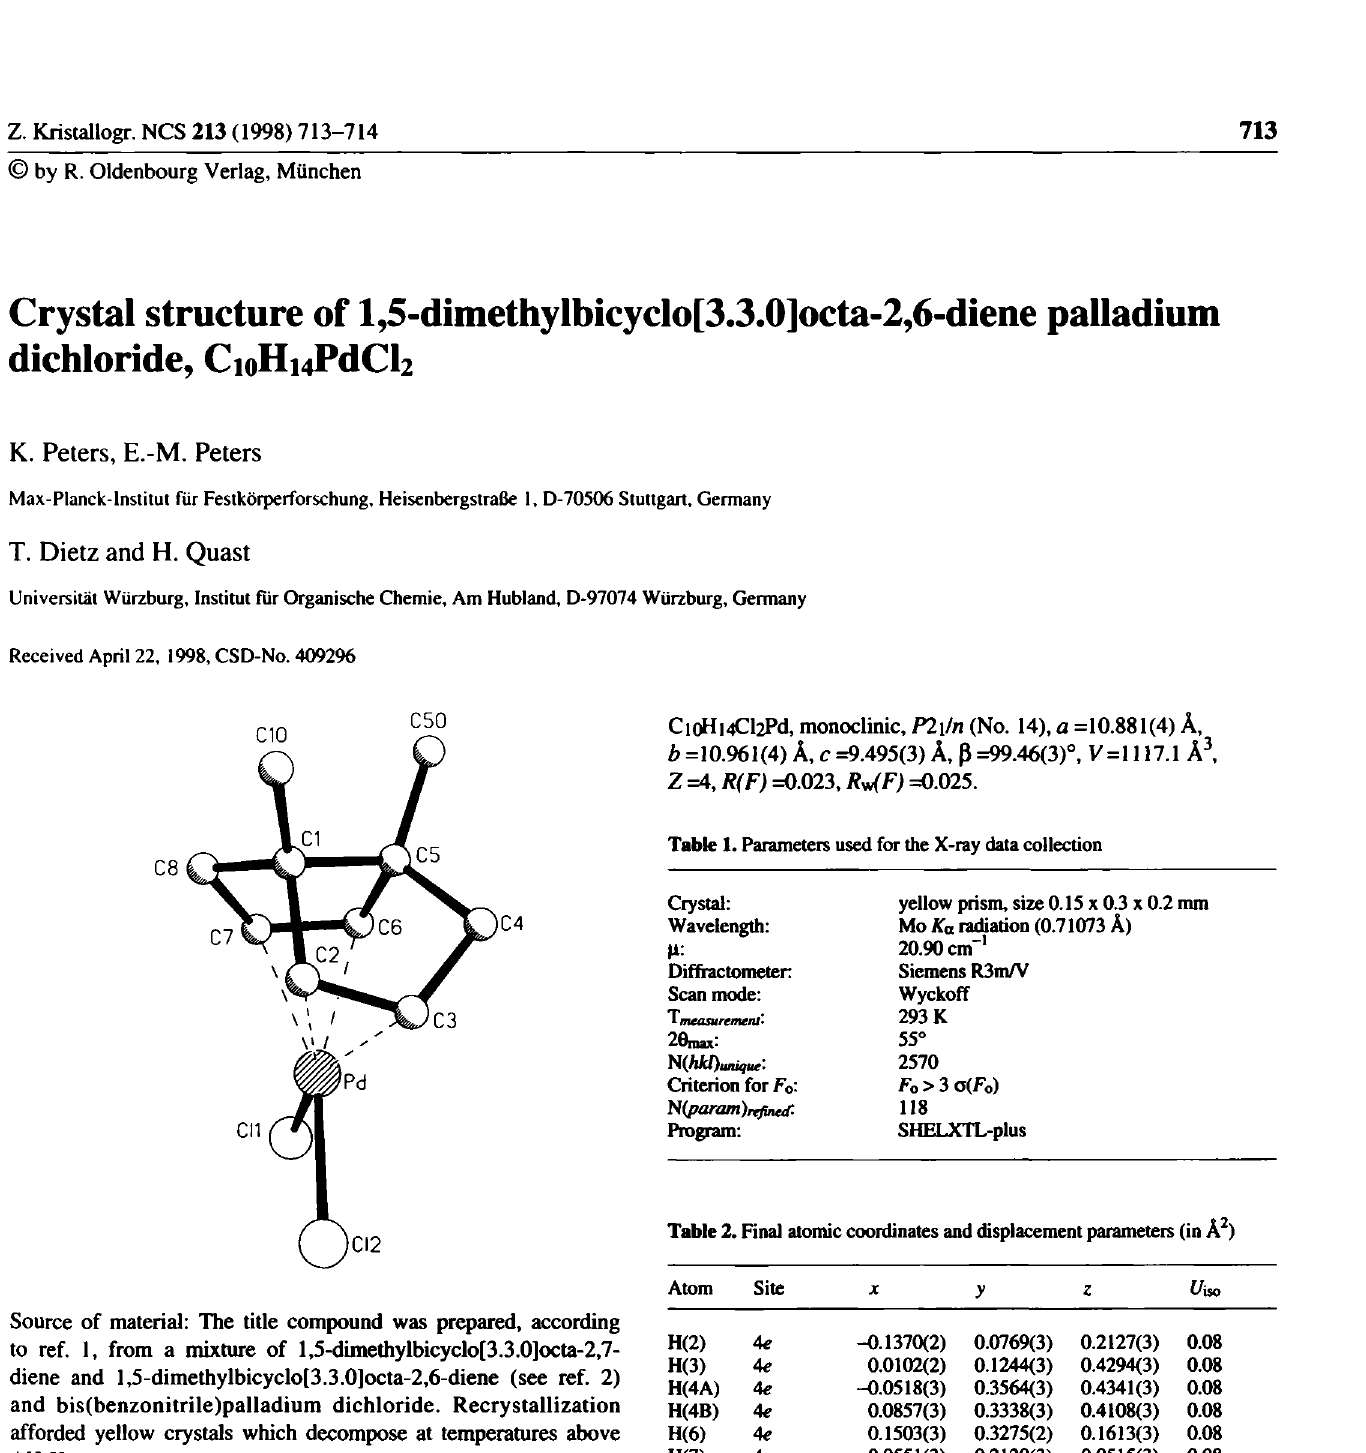
Table 2. Final atomic coordinates and displacement parameters (in